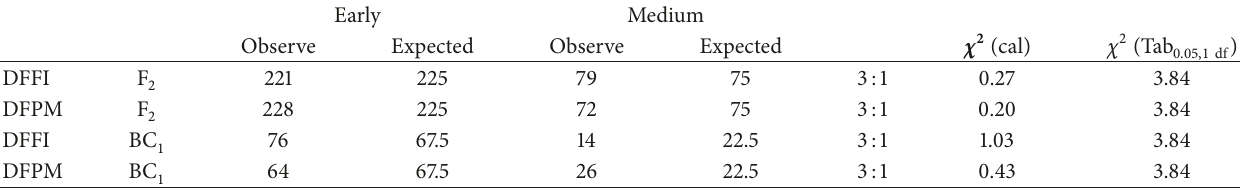
Table 3: Segregation pattern for maturity indices in F 2 and BC 1